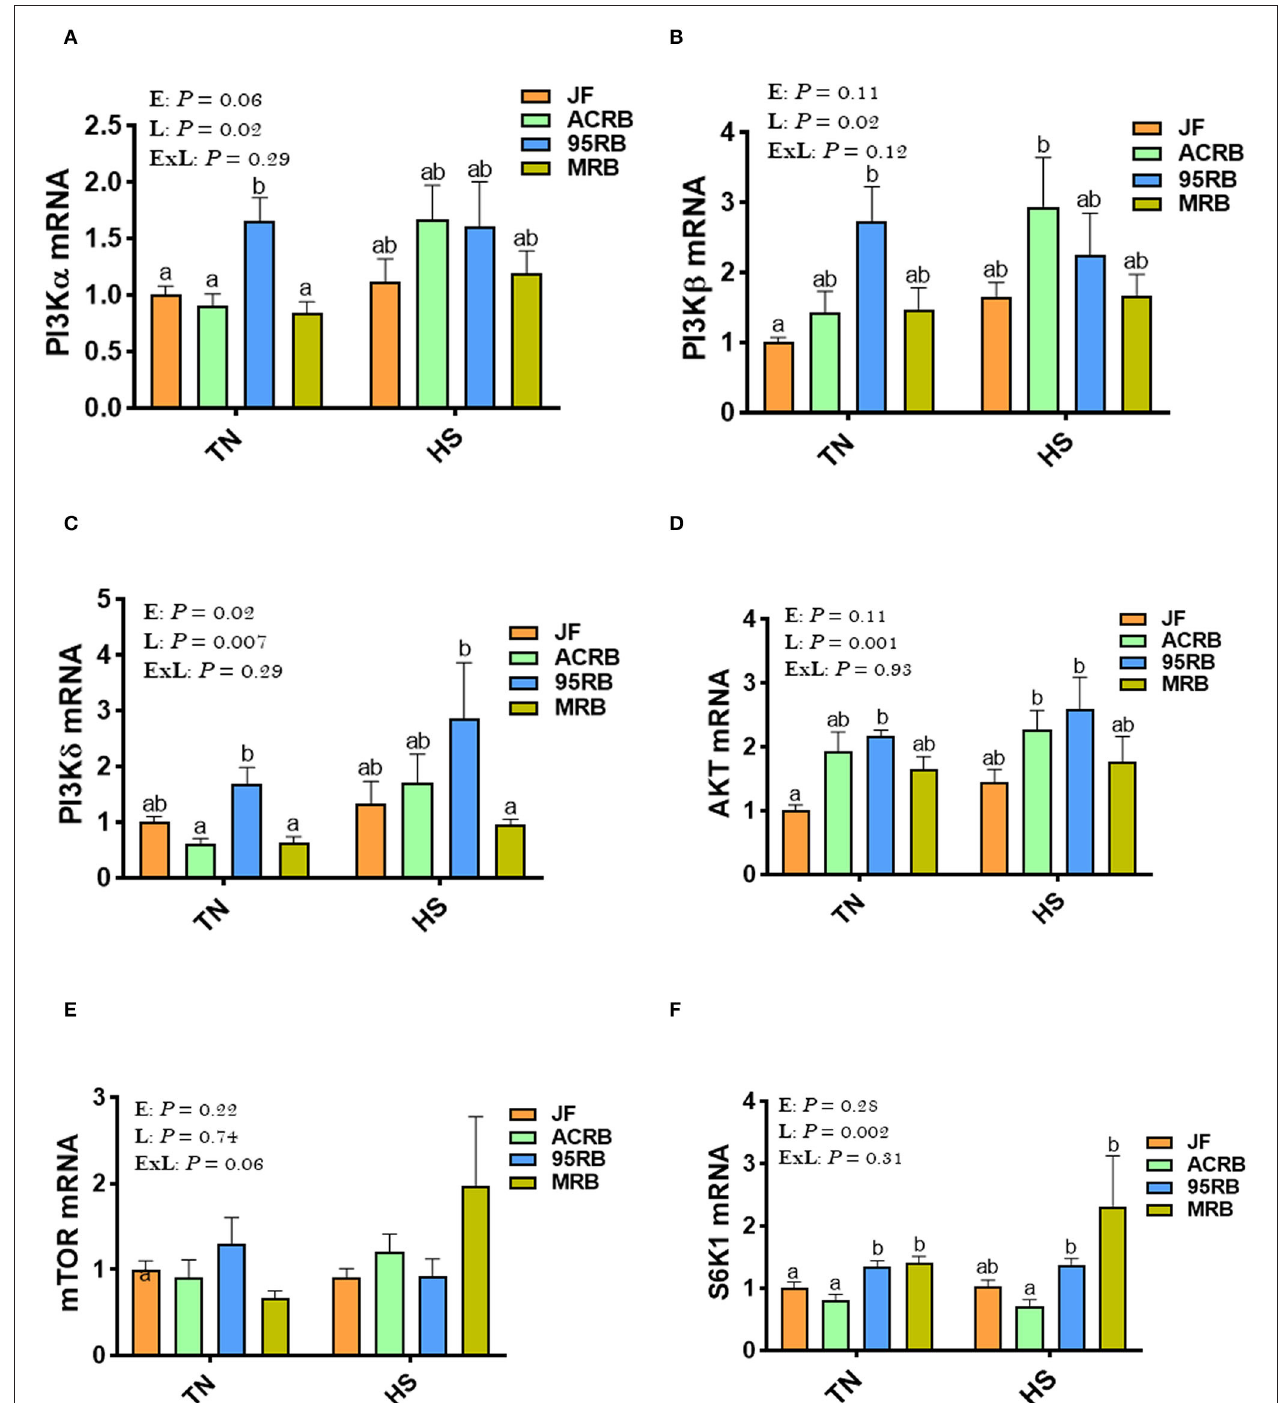
FIGURE 4 | Effect of HS on hypothalamic expression of PI 3 K-mTOR-S6K1 pathway in three modern broilers and their ancestor JF. RNA was extracted from hypothalamic tissues and analyzed by qPCR using 2 − 11 CT method. Data for gene expression of PI3K α (A) , PI3K β (B) , PI3K γ (C) , AKT (D) , mTOR (E) , and S6K1 (F) are mean ± SEM ( n = 6/group). Different letters indicate significant difference at P < 0.05. 95RAN, 1995 random bred; ACRB, Athens Canadian Random Bred; AKT, protein kinase B; E, environment; ExL, interaction between E and L; HS, heat stress (36 ◦ C); JF, jungle fowl; L, line; MRB, modern random bred; mTOR, mechanistic target of rapamycin; PI3K, phosphatidylinositol 3-kinase; S6K1, Ribosomal protein S6 kinase beta-1; TN, thermoneutral (25 ◦